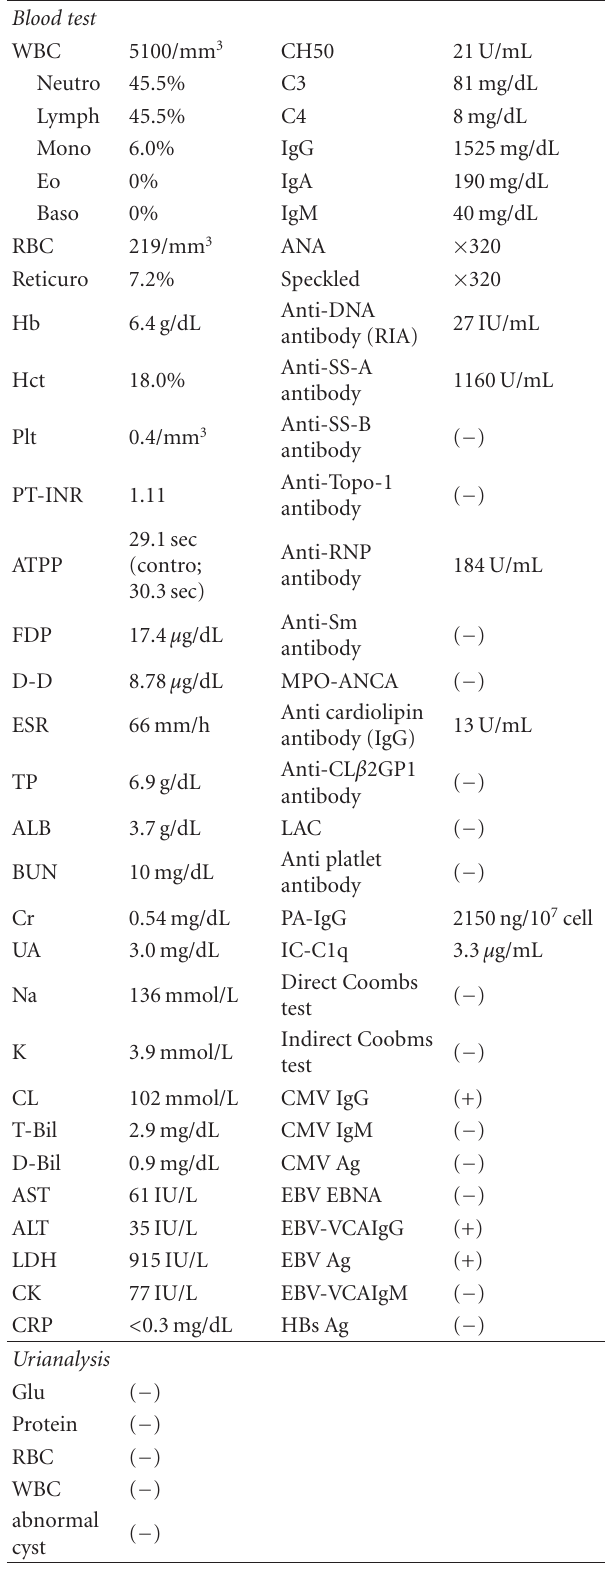
Table 1: Laboratory test results on admission.